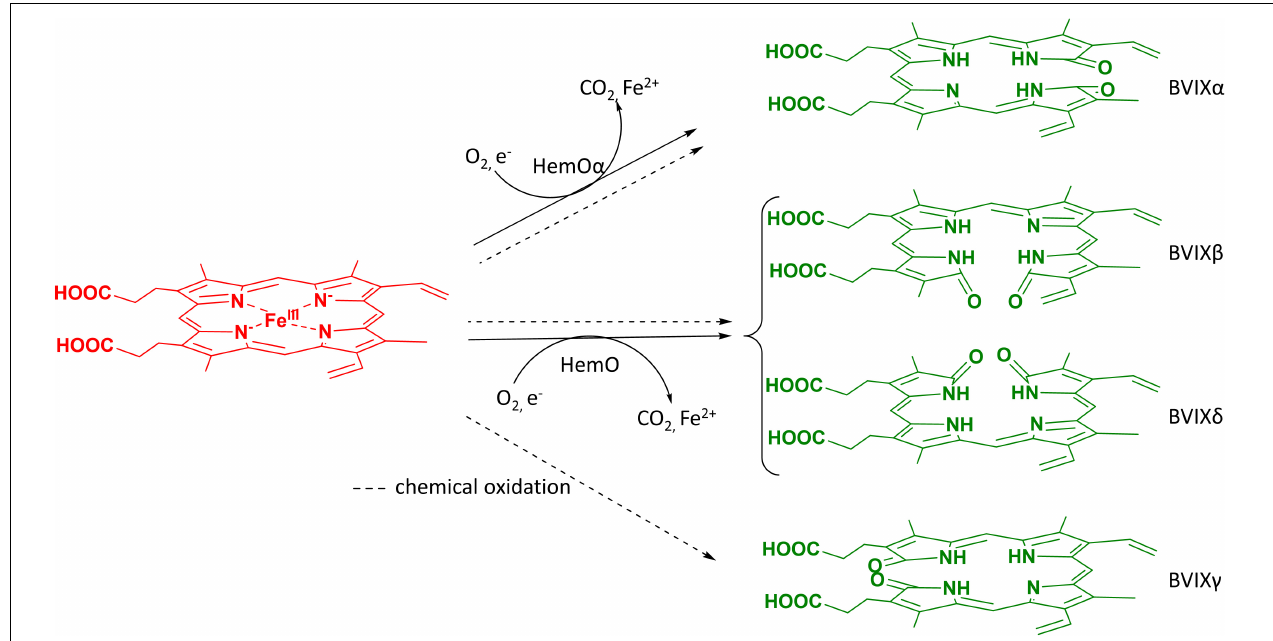
FIGURE 1 | BVIX isomers produced by heme oxygenase or chemical oxidation. Heme oxygenases (HO’s) including mammalian and bacterial catalyze heme to BVIX α , CO 2 , and Fe 2 + . P. aeruginosa HemO degrades heme releasing the BVIX β , and - δ isomers. All four isomers, including BVIX γ , are produced during the chemical oxidation